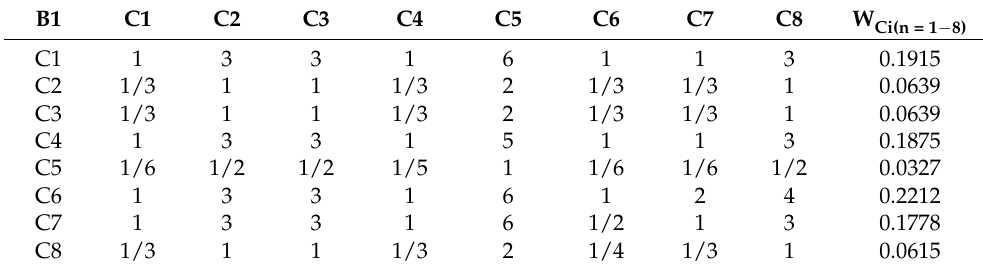
Table A2. B1-C i(i = 1–8) Judgment Matrix and Consistency Test.